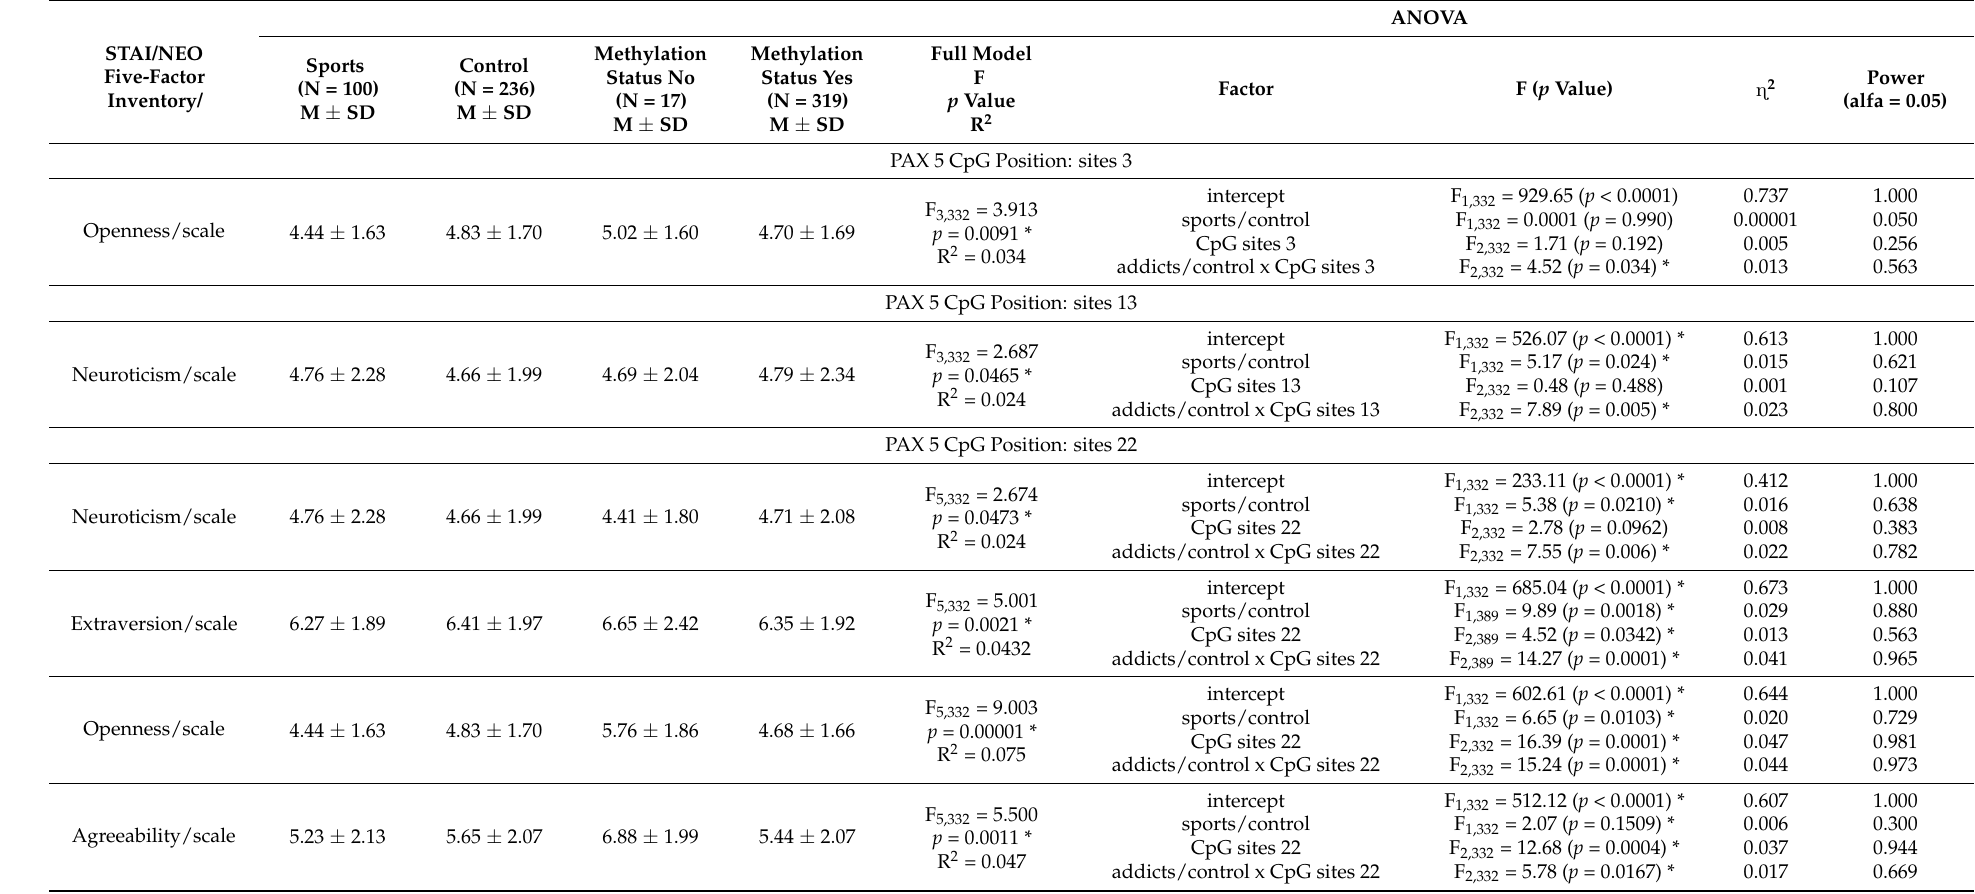
M—mean, SD—standard deviation. *—Statistically significant between-group